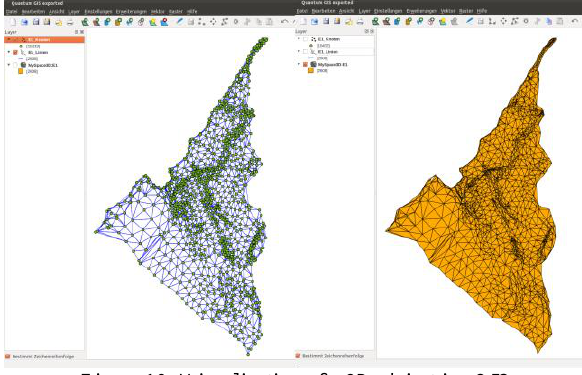
Figure 10: Visualization of a 3D object in qGIS